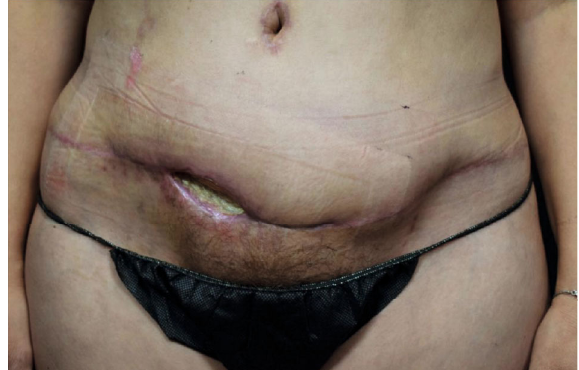
Figure 2: The patient ’ s ventral view with healing contracted wound following initial